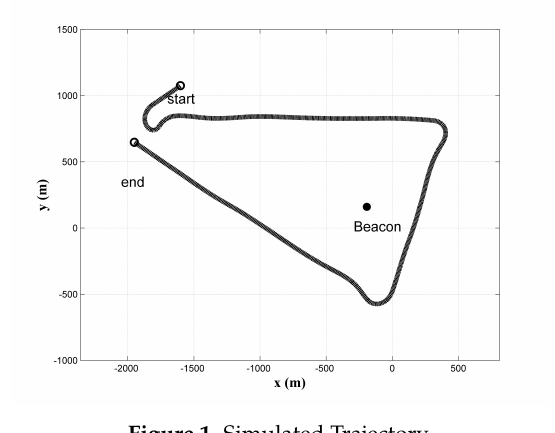
Figure 1. Simulated Trajectory. Table 1. Sampling frequency and noise level of simulated